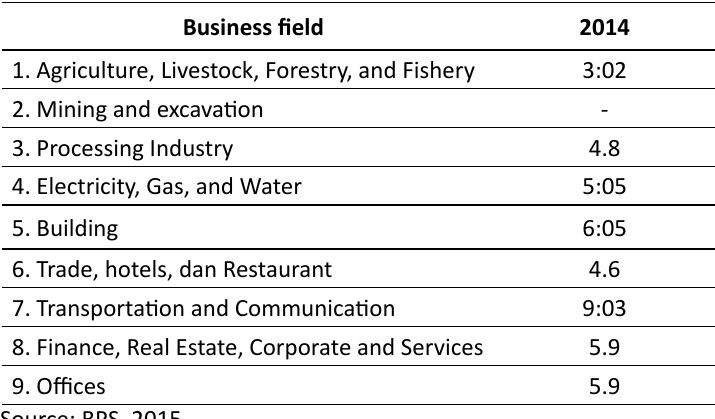
Table 1: The growth rate of Gross Domestic Product by Industrial Origin at Constant